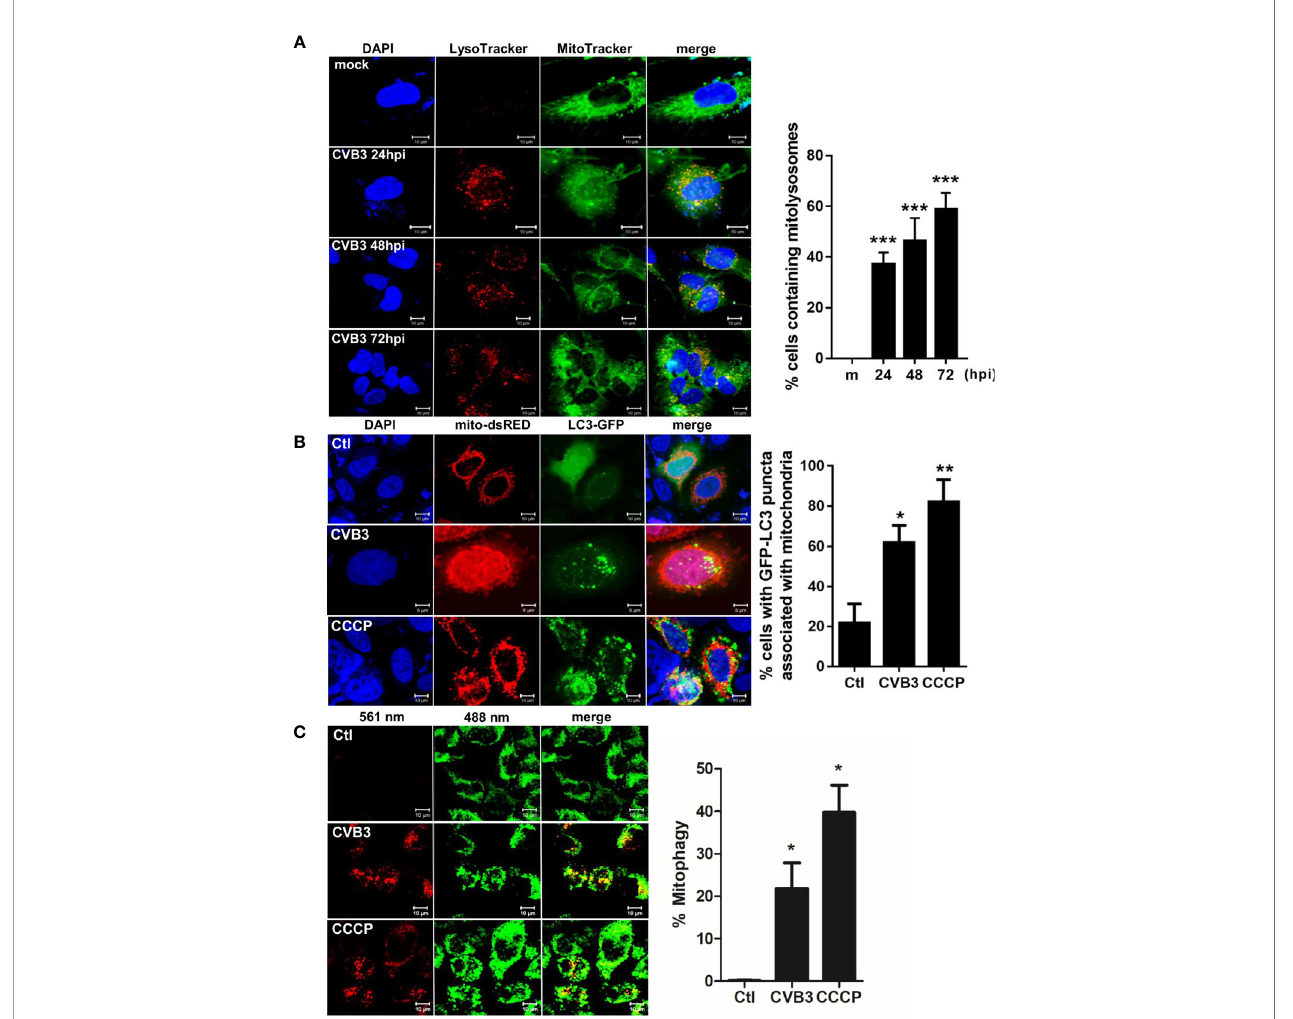
FIGURE 2 | Induction of mitophagy following CVB3 infection. (A) hNPCs were infected with mock (m) or CVB3 at an MOI of 5 for the indicated time points. The cells were subsequently stained with MitoTracker Green and LysoTracker Red. Scale bar=10 m m. Percentage (%) of cells containing mitolysosomes is quanti fi ed and represented as a graph on the right. At least 100 cells were counted per experiment (n=3) (B) HeLa-Parkin cells were transfected with LC3-GFP (green) and mito- dsRED (red) plasmids and infected with CVB3 for 8 h or treated with control DMSO (Ctl) CCCP for 2 h. Scale bar=10 m m. Percentage (%) of cells with LC3 puncta associated with mitochondria is quanti fi ed and represented as a graph on the right. (C) HeLa-Parkin cells expressing mt-Keima were either treated with 25 m M CCCP for 2 h or infected with CVB3 for 8 h. The emission signal obtained after excitation with the 488 nm laser is shown in green, and that obtained after excitation with the 561 nm laser is shown in red. Zeiss ZEN software was used to determine changes in pH-dependent fl uorescence and % mitophagy is represented in graph. Scale bar =10 m m. Bar graph shows mean ± SD from at least 100 cells/condition compiled from three experiments. *p < 0.05; **p < 0.01; ***p < 0.001 vs . control DMSO- treated